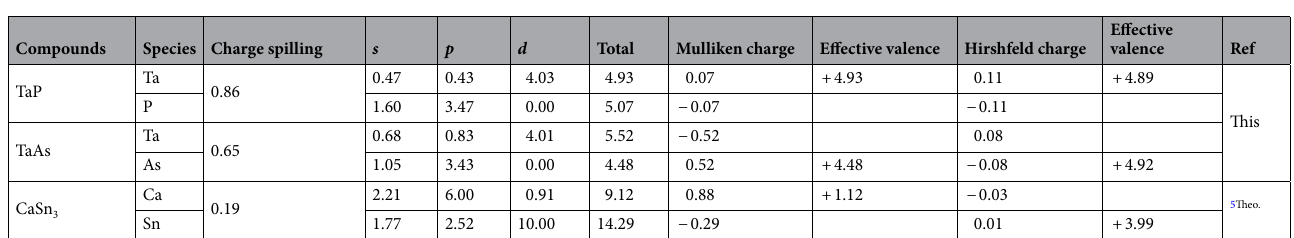
Table 10. Charge spilling parameter (%), orbital charges (electron), atomic Mulliken charges (electron), effective valence (electron) and Hirshfeld charge (electron) in TaP and TaAs. For comparison, we have displayed the results of bond population analysis of CaSn 3 WSM in this